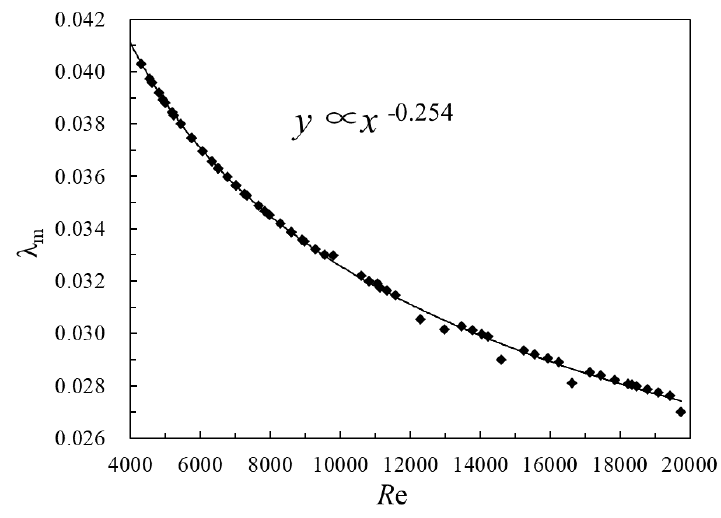
Figure 10. Relationship between the Re number and the resistance coefficient λ m R.